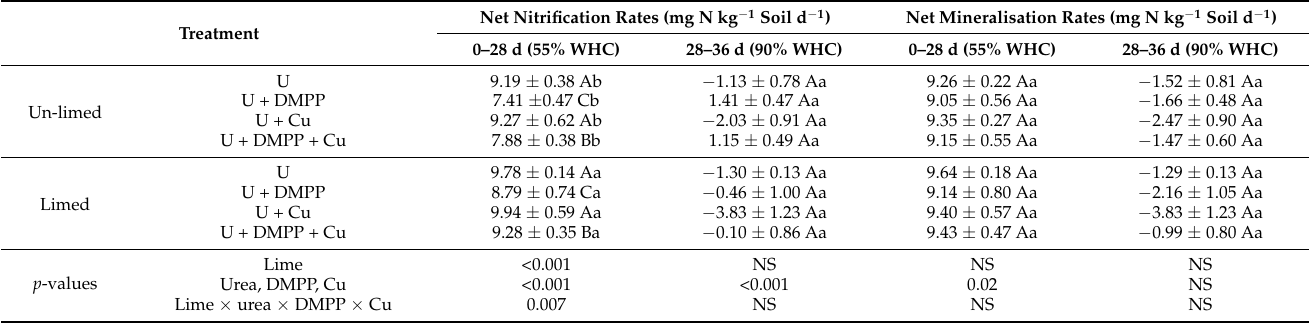
Table 1. Net nitrification and net mineralisation rates (mg N kg − 1 soil d − 1 ) in the soil at different periods of incubation. Soils were maintained at 55% WHC for the first 28 d then increased to 90% WHC for the remainder of the experimental period. Data are the means of four replicates ± SE.